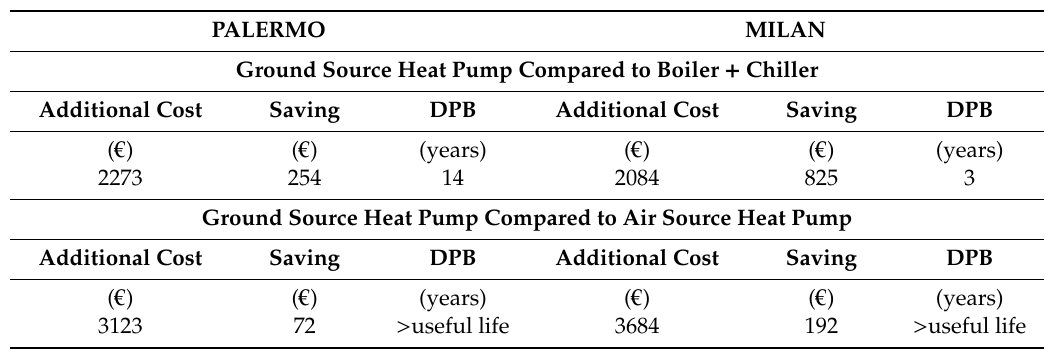
Table 9. Savings and discounted payback (DPB) periods for the three analysed heating, ventilation and air-conditioning (HVAC) configurations, for Palermo and